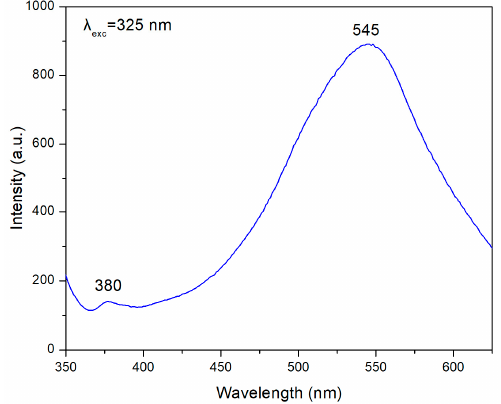
Figure 5. PL spectrum recorded by using an excitation wavelength at 325 nm over the ZnO film deposited onto the Metglas 2826MB strip.